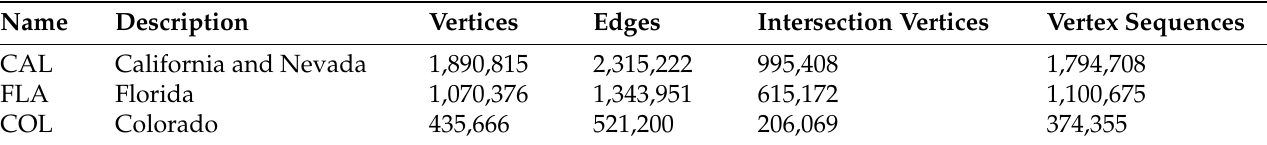
Table 5. Real-world roadmaps.